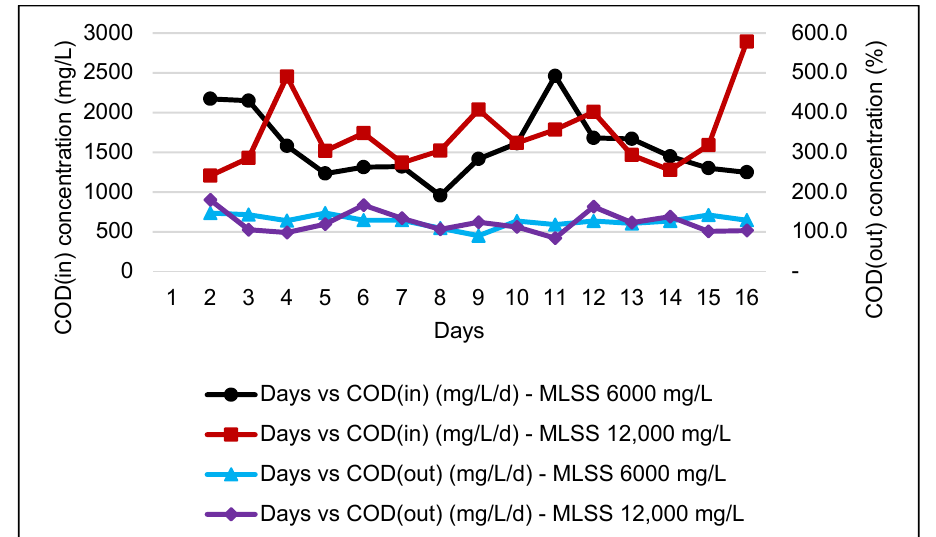
Figure 4. COD concentration of influent and effluent for an MBR system at MLSS values of 6000 mg/L and 12,000 mg/L by using an FS membrane.